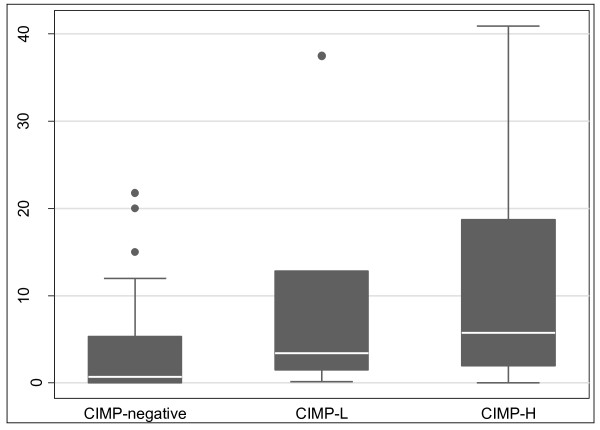
THBS4 methylation increases with increasing CIMP methylation. Tumours were stratified according to the Laird classification of CIMP, separated into CIMP-neg (0/5 markers positive for methylation), CIMP-low (1/5 or 2/5 markers positive for methylation) and CIMP-high (3, 4 or 5/5 markers methylation positive) categories of methylation. THBS4 methylation was found to positively correlate with CIMP. The greater the number of Laird markers that were positive for CIMP, the higher the level of THBS4 promoter methylation. The median PMRs were 0.69 for CIMP-negative tumours, 3.4 for CIMP-L tumours, and 5.8 for CIMP-H tumours (p = 0.033).